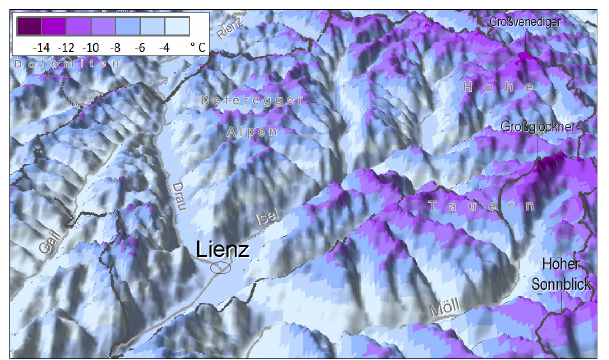
Figure 2. Map example 1. Mean monthly air temperature in Jan- uary, bird eye’s view on map section for East Tyrol (westward view, vertical exaggeration 2:1). Note the embedded e ff ect of mesocli- mate modification on